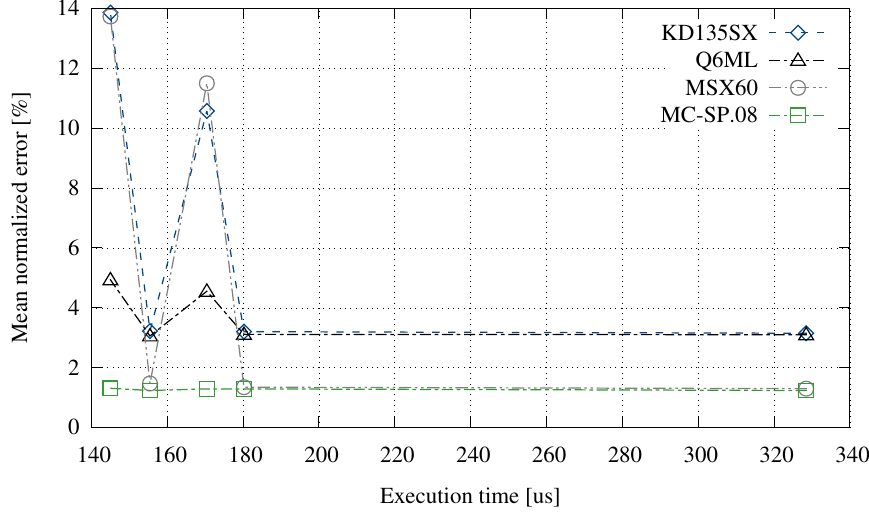
Figure 11. Execution times vs. MNE for each PV